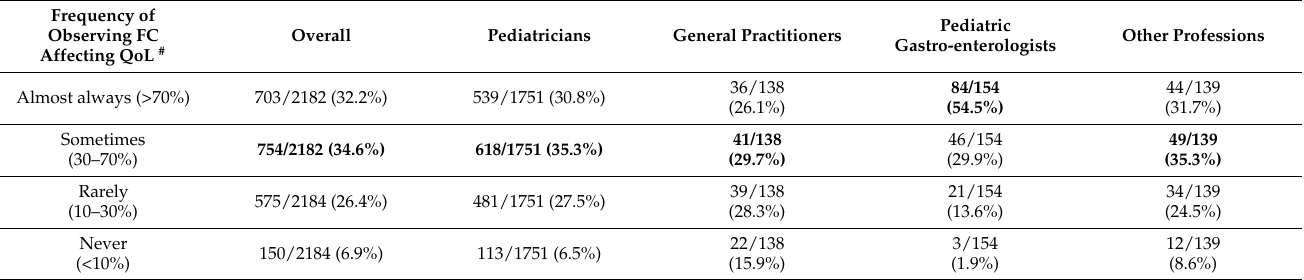
Table 1. The frequency of HCPs by profession reporting to have observed FC affecting (QoL) of infants and their parents in the last week.